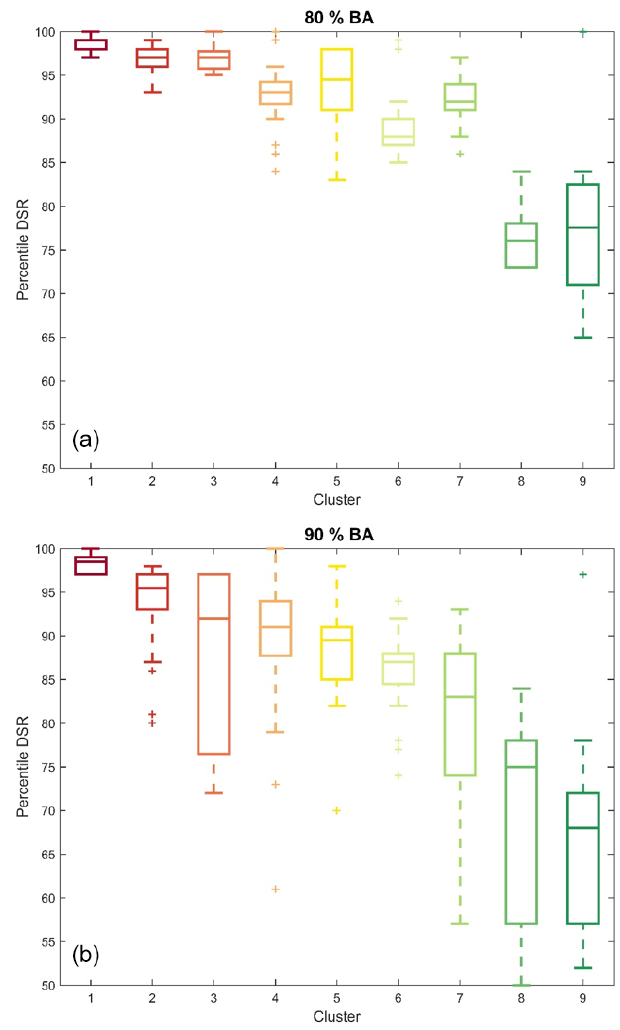
Figure 9. Boxplots of DSRp80TBA (a) and DSRp90TBA (b) , i.e. the DSRp associated with 80% and 90% of TBA, respectively, for the nine clusters. The central line is the median; the edges of the box are the 25th and 75th percentiles; and, the plus signs represent out- liers, defined as a value that is more than 3 scaled median absolute deviations away from the median.